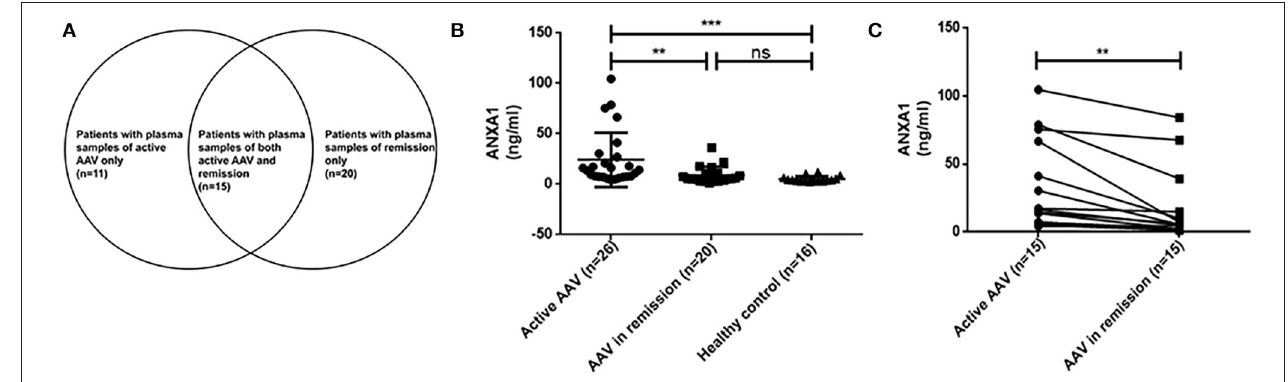
FIGURE 1 | Details of plasma samples of AAV patients (A) . Plasma levels of ANXA1 in active AAV patients ( n = 26) and controls (AAV in remission, n = 20; healthy control, n = 16) (B) . Comparisons of ANXA1 levels in 15 AAV patients with sequential plasma samples (pairs = 15) (C) . AAV, anti-neutrophil cytoplasmic antibody (ANCA)-associated vasculitis; ANXA1, annexin A1; ns, no significance ( P > 0.05). ** P < 0.01, *** P <